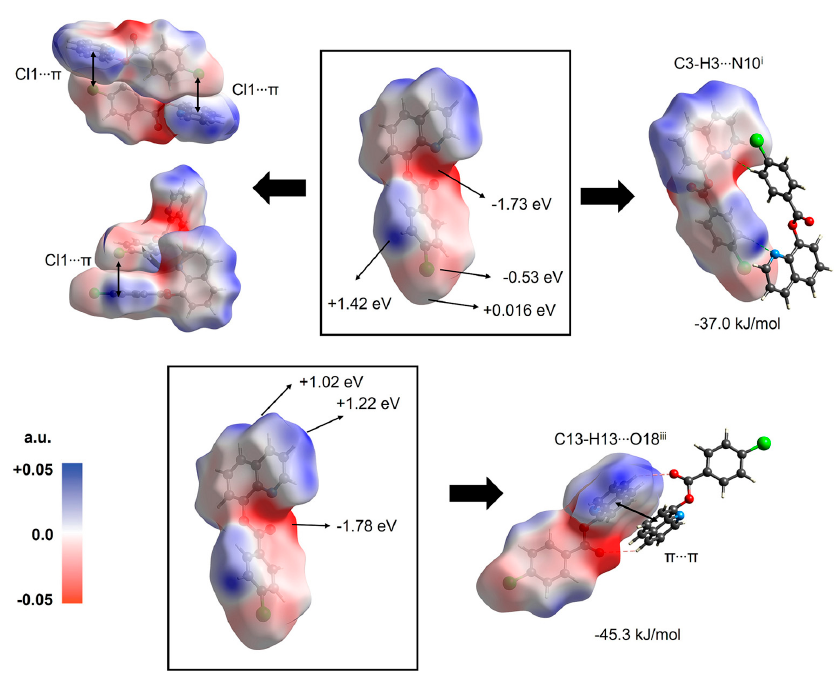
Figure 9. ESPs mapped on Hirshfeld surfaces were mapped over the range − 0.05 a.u. (red), through zero (white), to +0.05 a.u. (blue) for compound 3 . zero (white), to +0.05 a.u. (blue) for compound 3 .